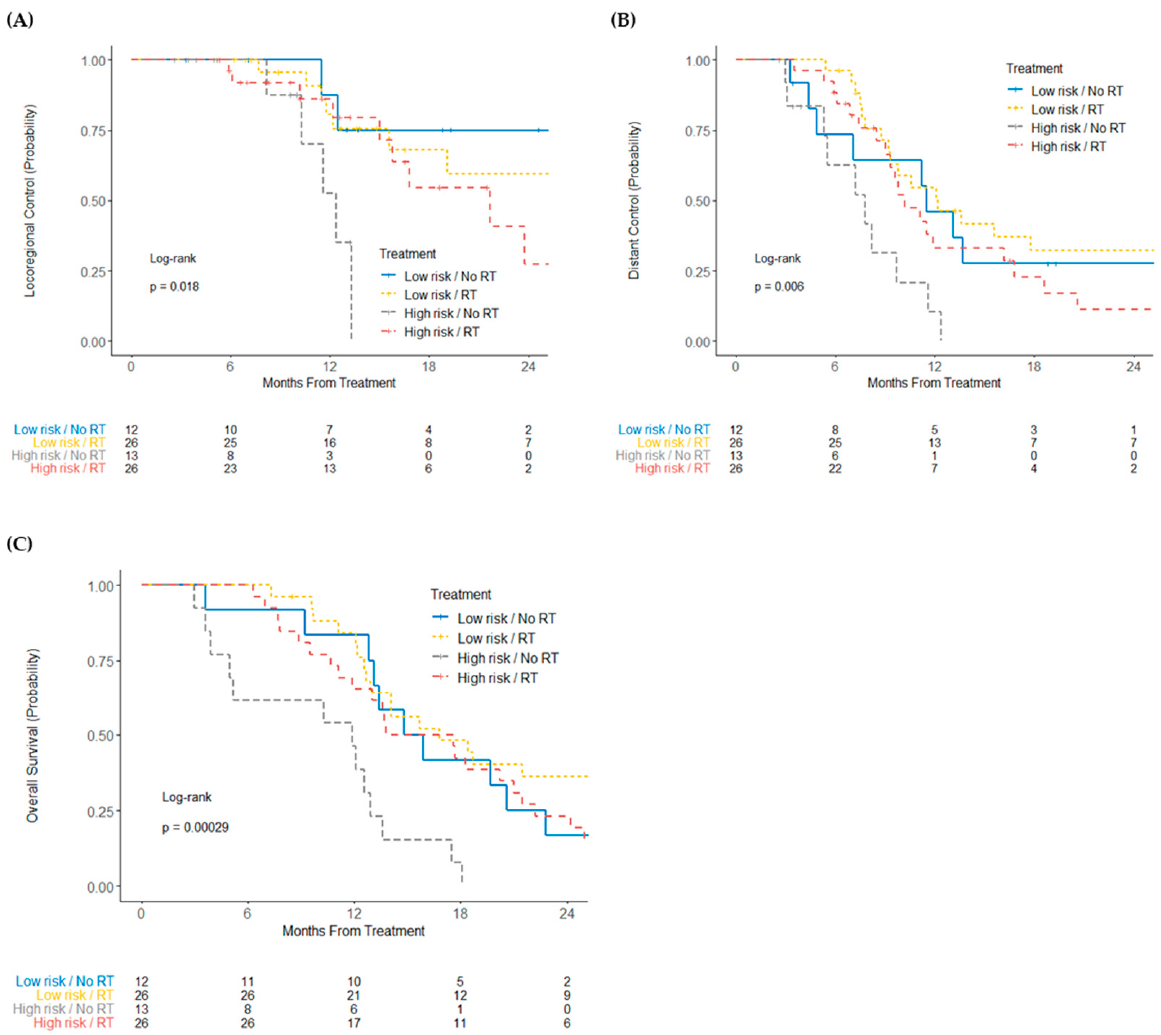
Figure 4. Kaplan–Meier curves of ( A ) locoregional control, ( B ) distant control, and ( C ) overall survival of patients with unresectable or borderline resectable pancreatic cancer, stratified by risk score group and receipt of radiation.